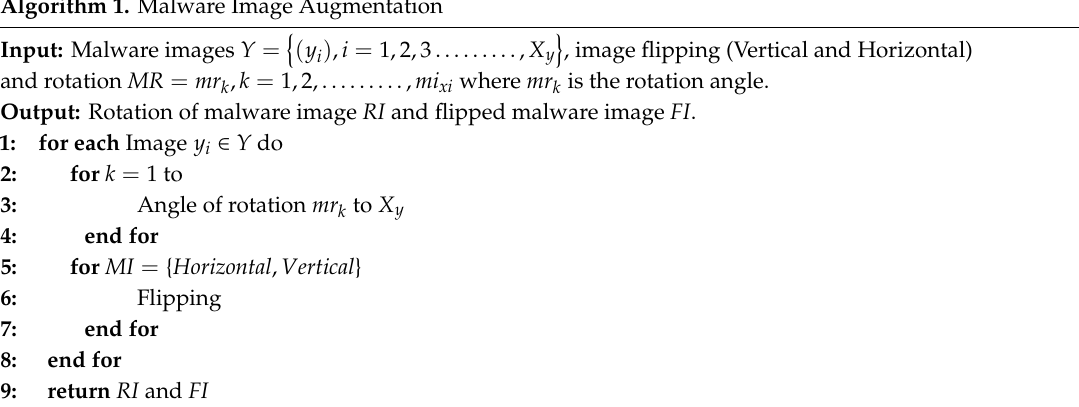
Algorithm 1. Malware Image